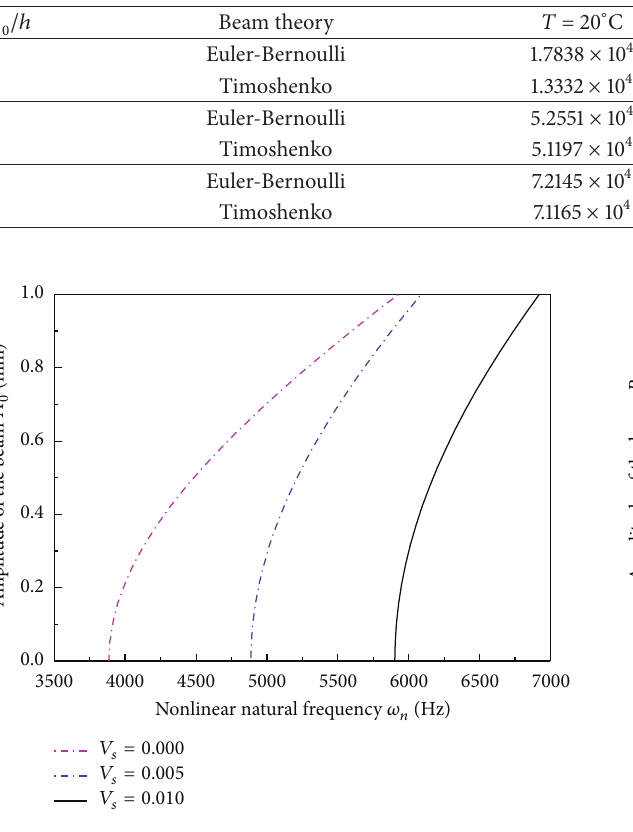
Figure 5: Variation of the nonlinear natural frequency with the free vibration amplitude 𝐴 0 for different 𝑉 𝑠 ( T = 50 ∘ C, 𝜀 0 = 0.005 , and 𝐿/ℎ = 10 ).